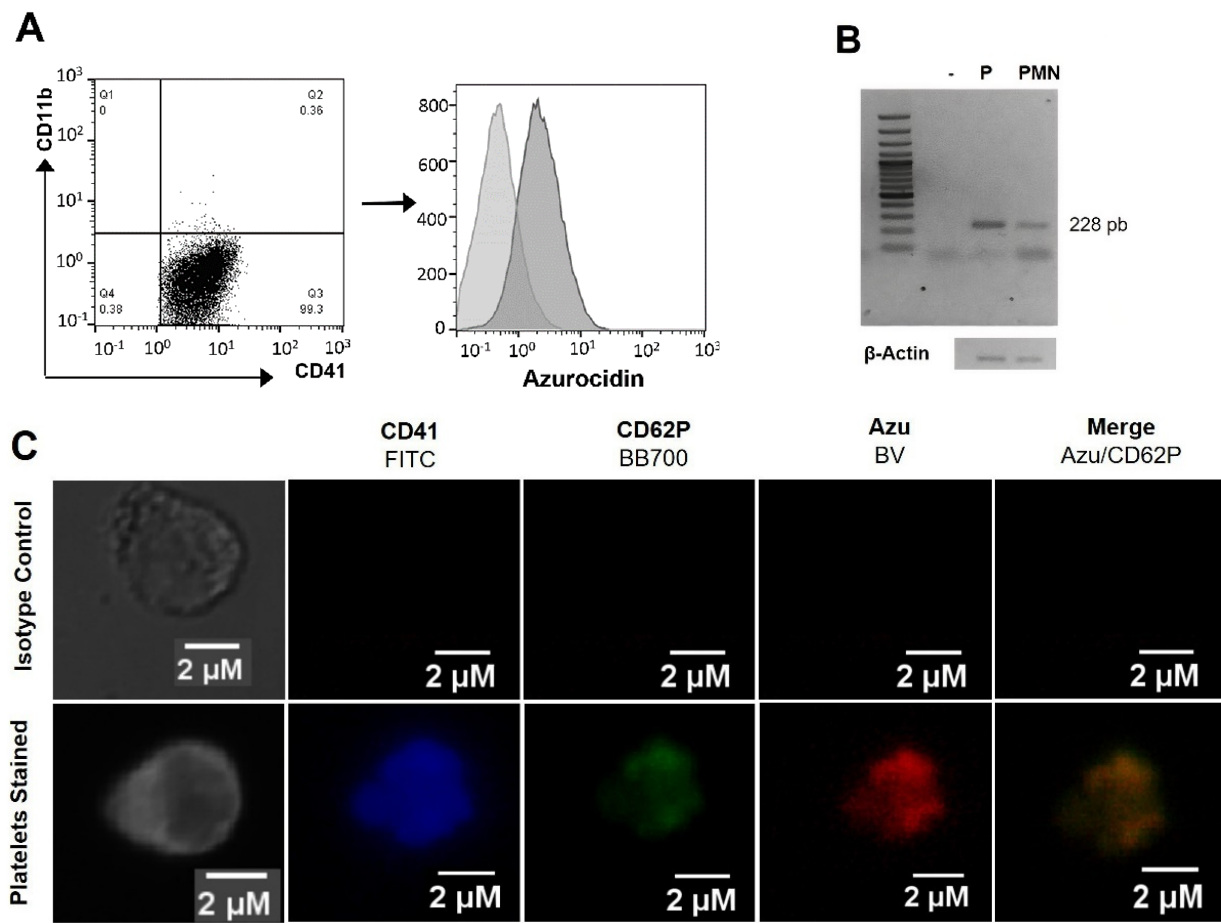
Figure 1. Human platelets express azurocidin mRNA, and the protein is localized in the α − granules. ( A ) flow cytometry analysis of platelets purified from peripheral blood of healthy donors. Surface staining with CD41 was used as a lineage marker and CD11b to exclude leukocyte contamination. Azurocidin expression comes from a prior selection of the CD41 + population, and the dark gray histogram represents intracellular staining with a mAb specific for azurocidin; the light gray histogram indicates staining with the isotype control mAb. ( B ) RT-PCR amplicons of azurocidin in platelets (P) and polymorphonuclear leukocytes (PMN) resolved on 2% agarose gels, and β -actin expression was used as housekeeping control. Both ( A , B ) data are representative of five independent experiments ( C ). Confocal microscopy of purified platelets stained intracellularly with mAbs against CD41 (blue), CD62P (green), and azurocidin (red). The scale bar equals 2 µm (Representative images of three independent assays).